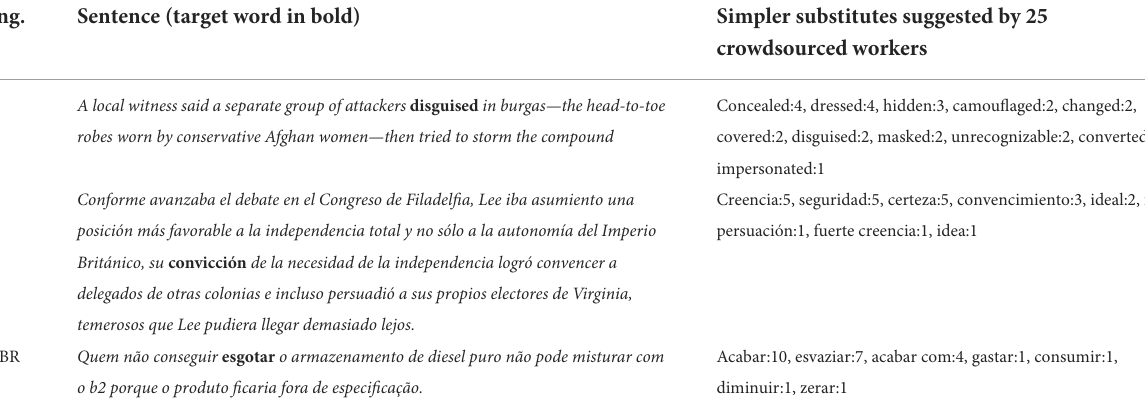
TABLE 3 Examples of instances from the dataset (the number after “:” in the third column represents the number of crowdsourced workers that suggested that replacement). Lang. Sentence (target word in bold) Simpler substitutes suggested by 25